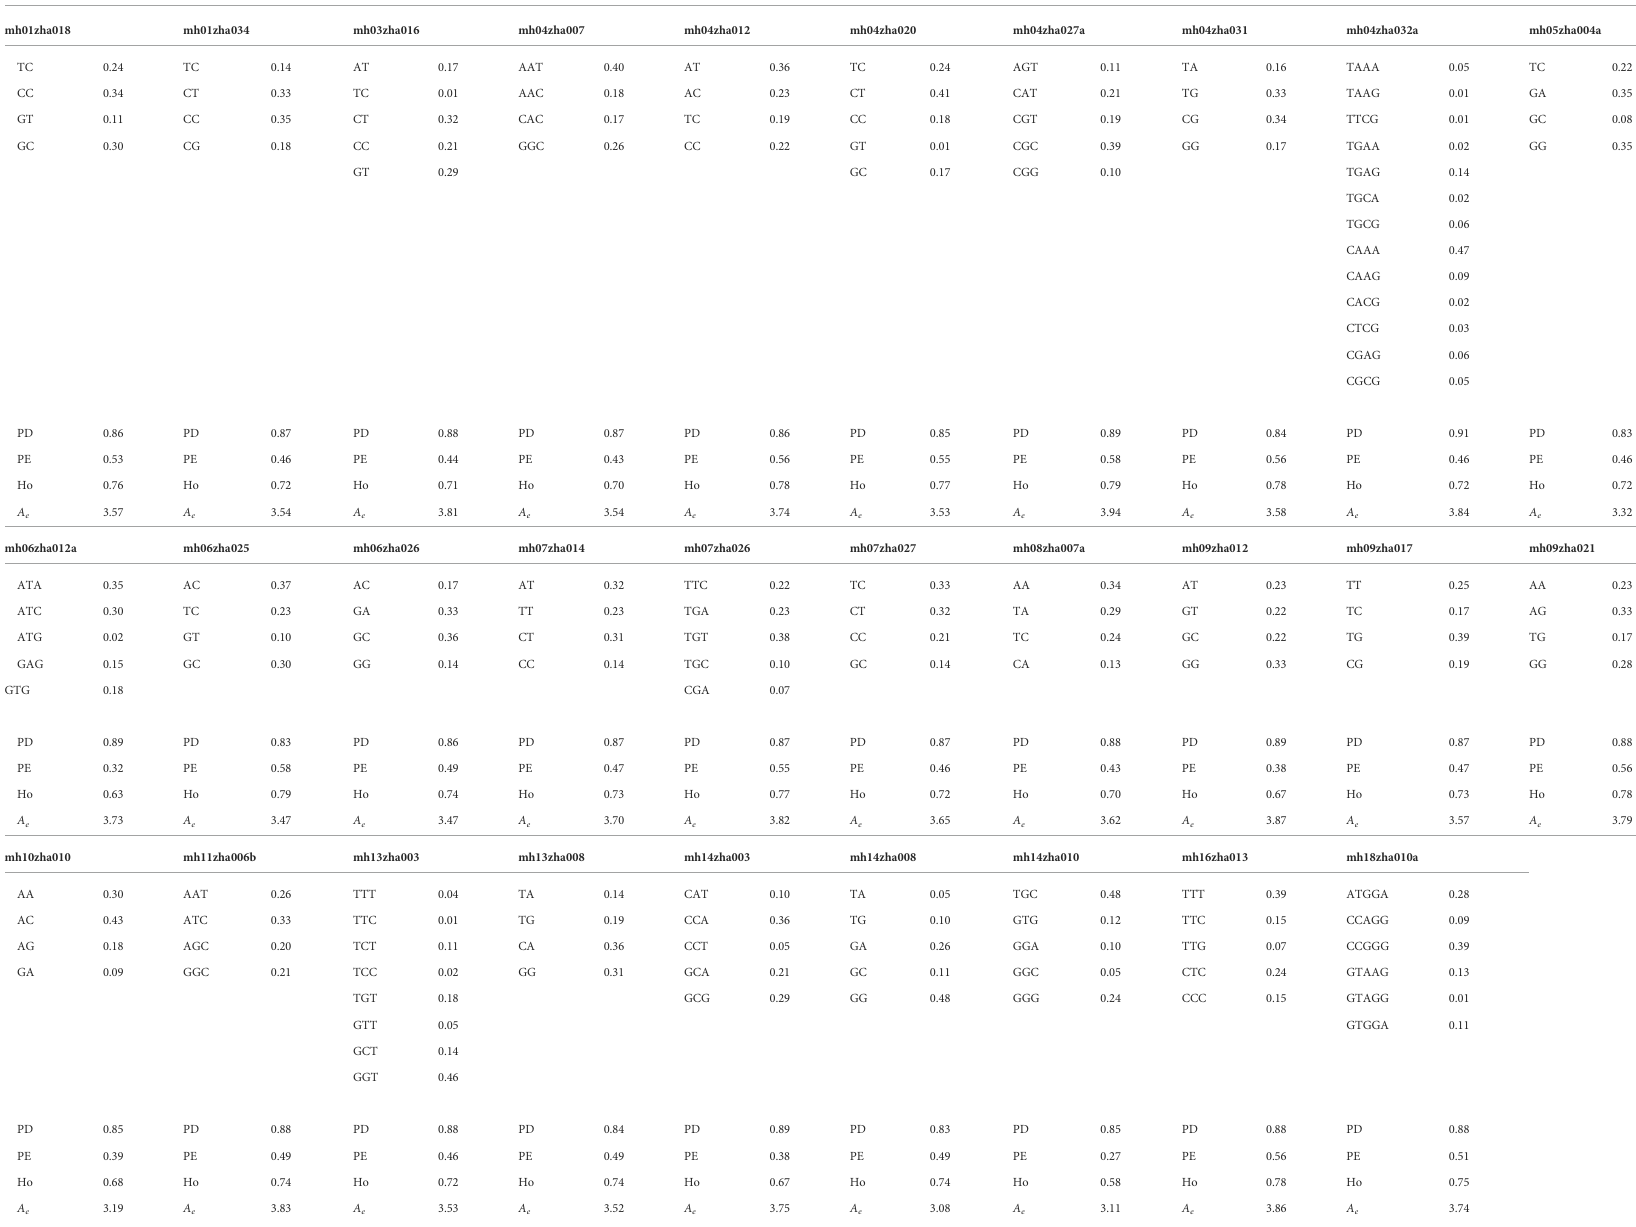
TABLE 2 Allelic frequencies and forensic parameters of the 29 microhaplotype loci based on the dataset of 96 unrelated Shandong Han Chinese from our study.